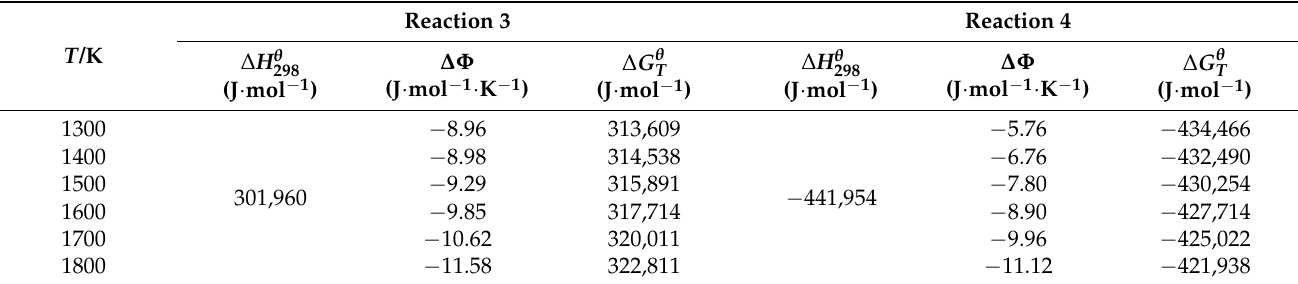
of Reaction 3 and Reaction T